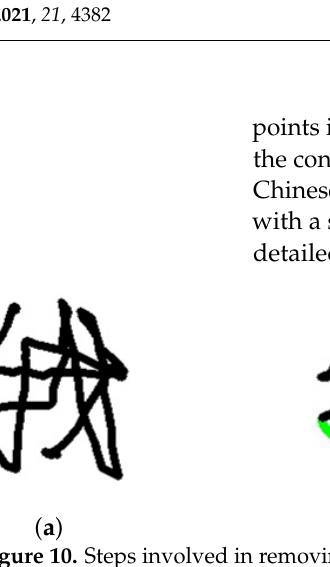
Figure 10. Steps involved in removing redundant connections from Chinese characters: ( a ) all trajectories appear in a single curve or stroke; ( b ) all redundant connections are found (the green segments represent the connections from the bottom right to the top left, while the red segments represent the connections from the bottom left to the top right with a steep slope); ( c ) all of the green segments are removed; and ( d ) the final results after the red segments are removed.